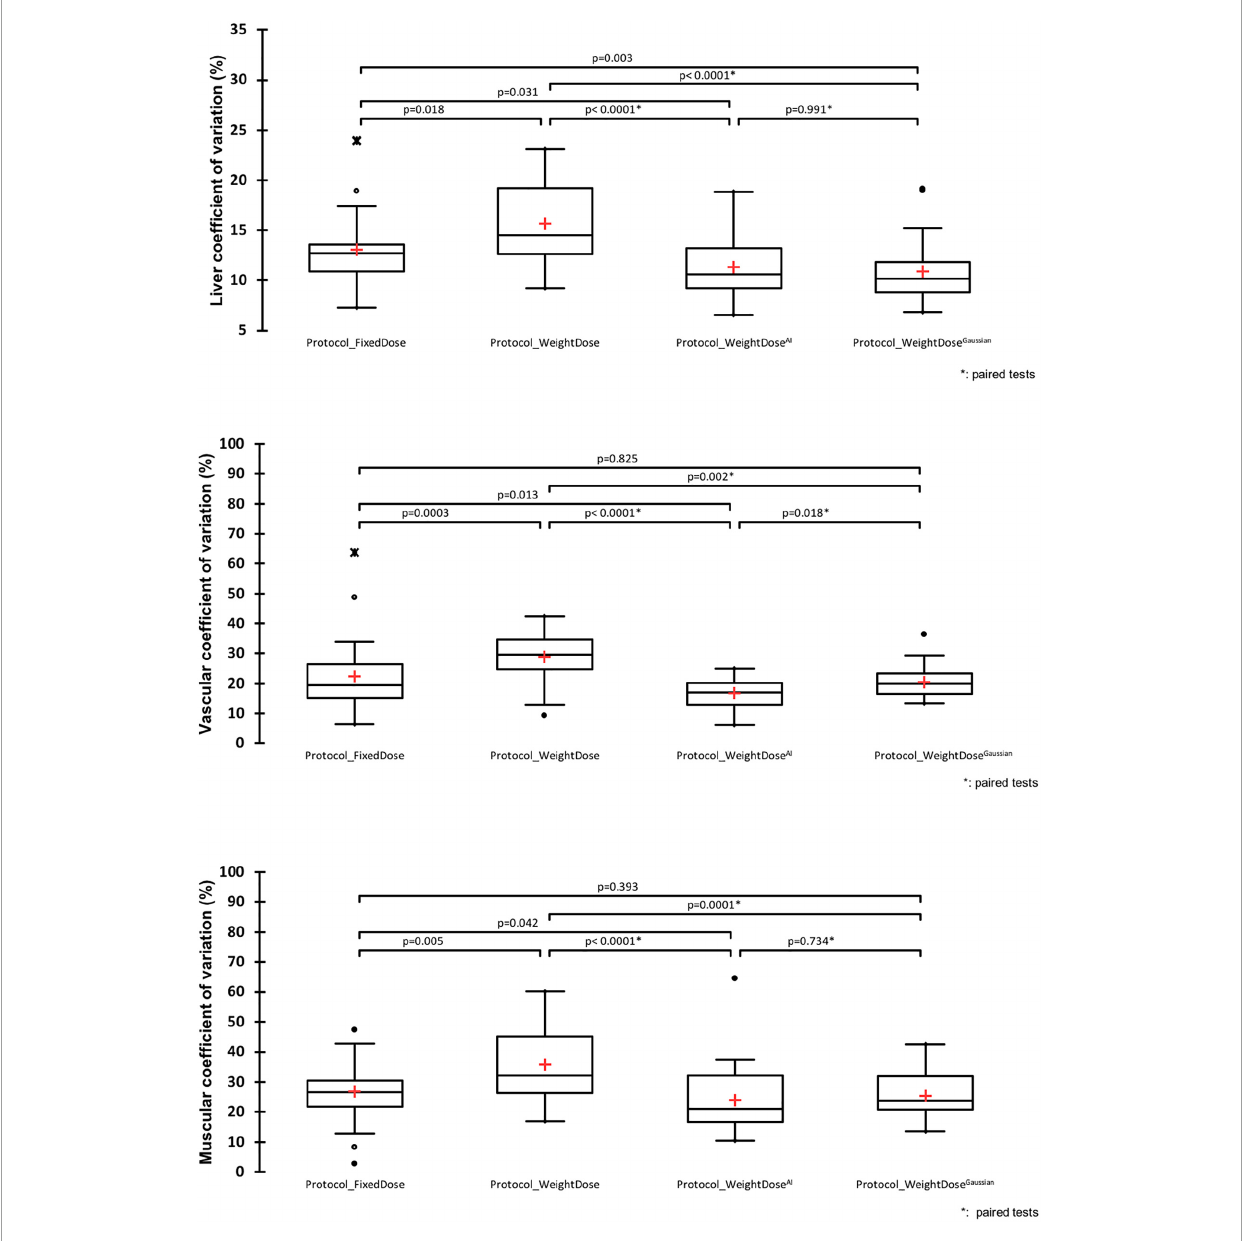
FIGURE1 Image noise analysis. ∗ Paired Wilcoxon tests were used to compare protocol_WeightDose and protocol_Weight dose AI data: Otherwise Mann–Whitney tests were used.